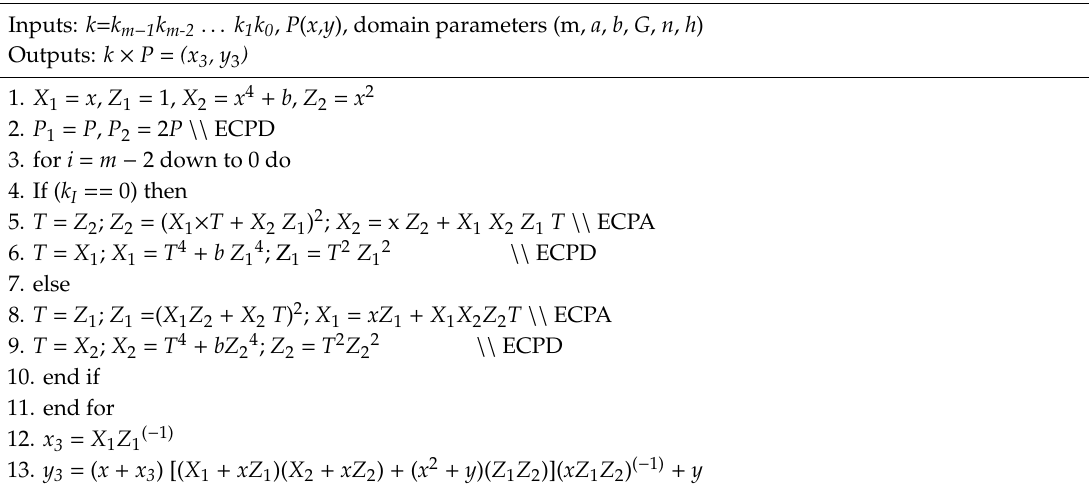
Algorithm 3. Montgomery ladder over projective coordinates, making field operations explicit.